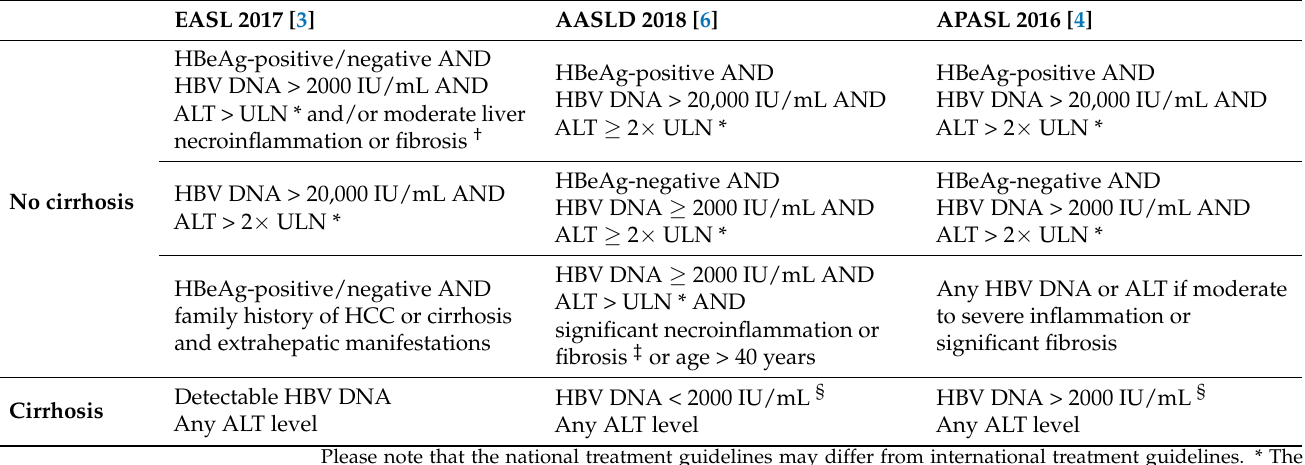
Table 1. Antiviral treatment criteria in the international